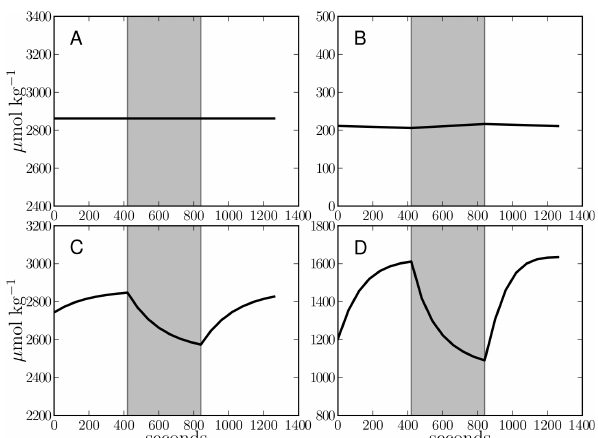
Fig. 6. Simulated total alkalinity over time (black lines) in the four model compartments ( A =seawater; B =tissue; C =coelenteron; D =calcifying fluid). Light periods range from 0 to 420s and from 840 to 1260s. The dark period is between 420 and 840s.